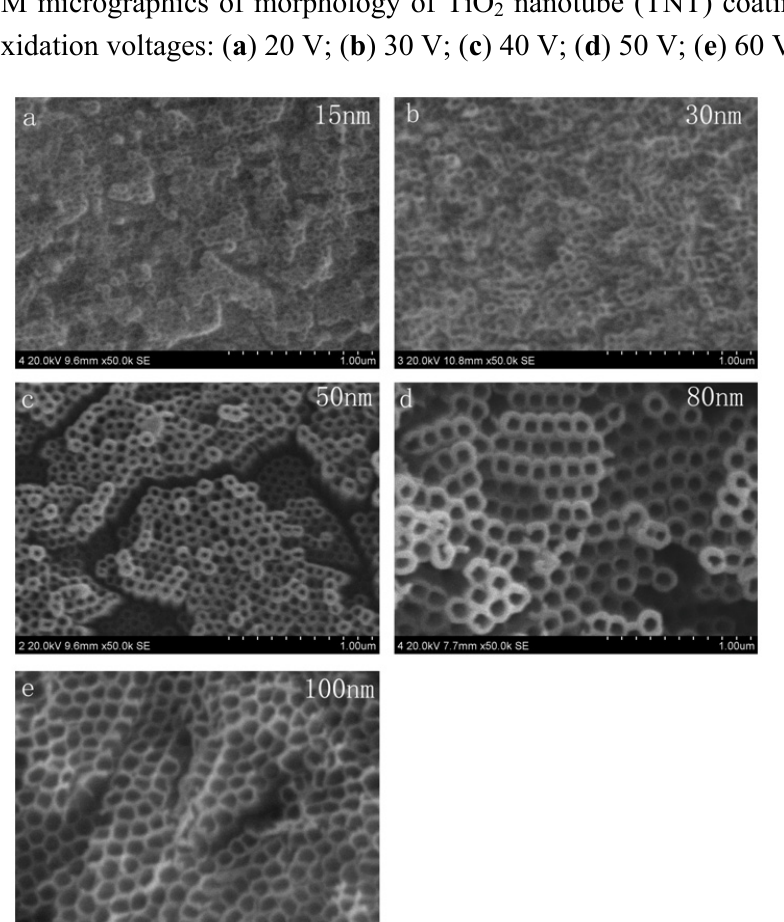
nanotube (TNT) coatings prepared 2